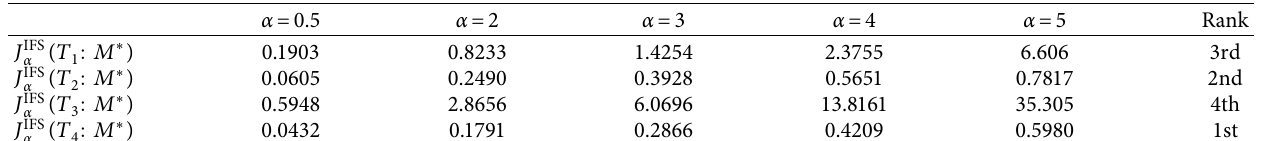
( T : M ∗ ) for different values of α i α